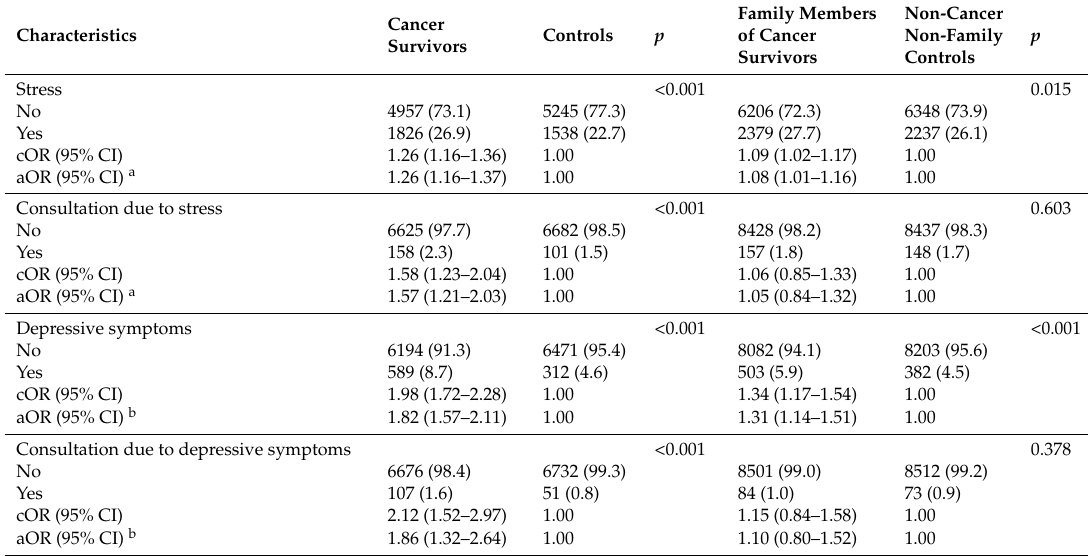
Table 2. Stress and depressive symptoms in cancer survivors, family members, and controls.